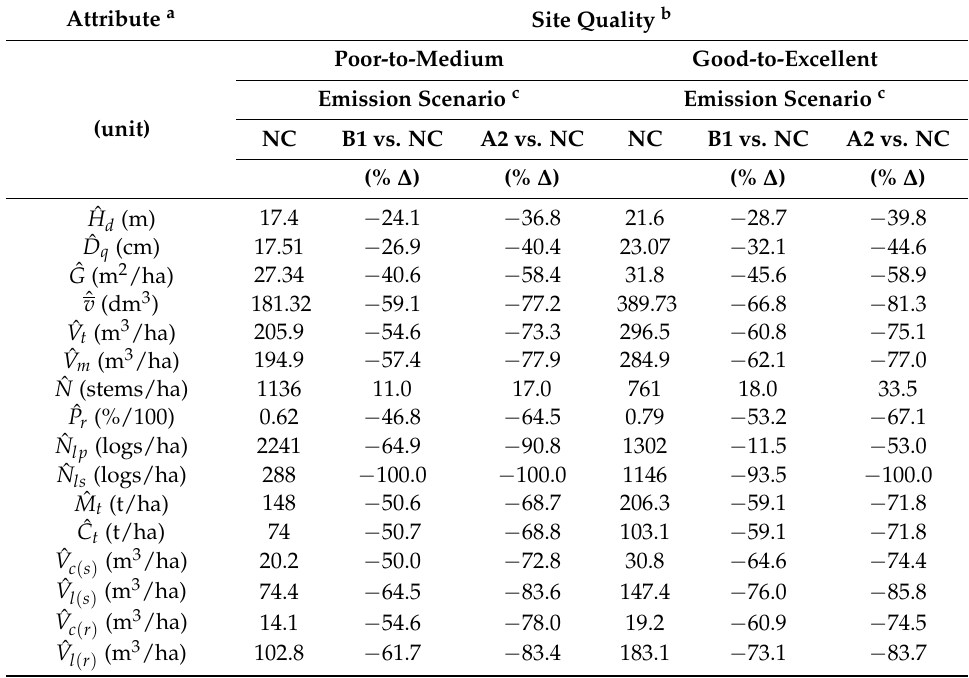
Table B3. Rotational yield estimates for jack pine plantations managed under a basic silvicultural intensity in north-western Ontario by emission scenario and site